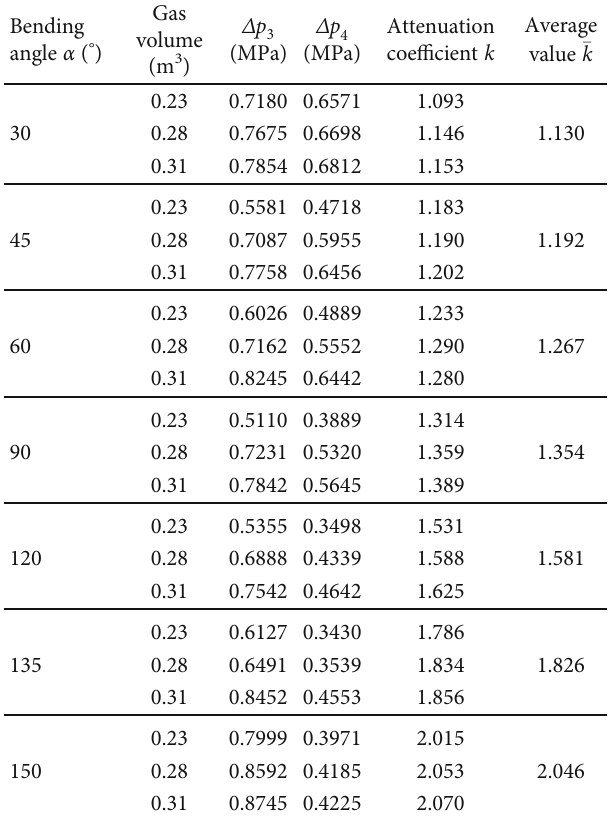
Table 3: Peak overpressure and attenuation coe ffi cient of explosion shock wave in bend